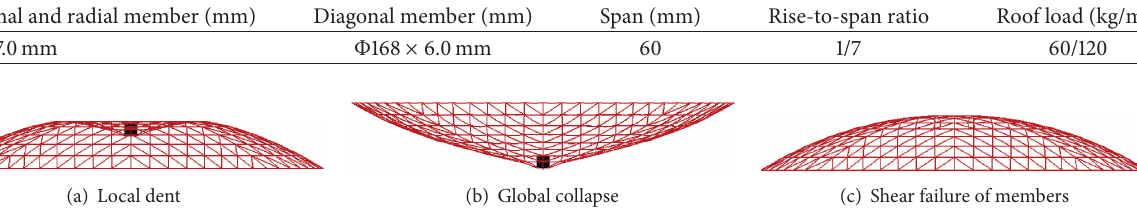
Table 1: Geometry parameters of single-layered kiewitt-8 reticulated dome.